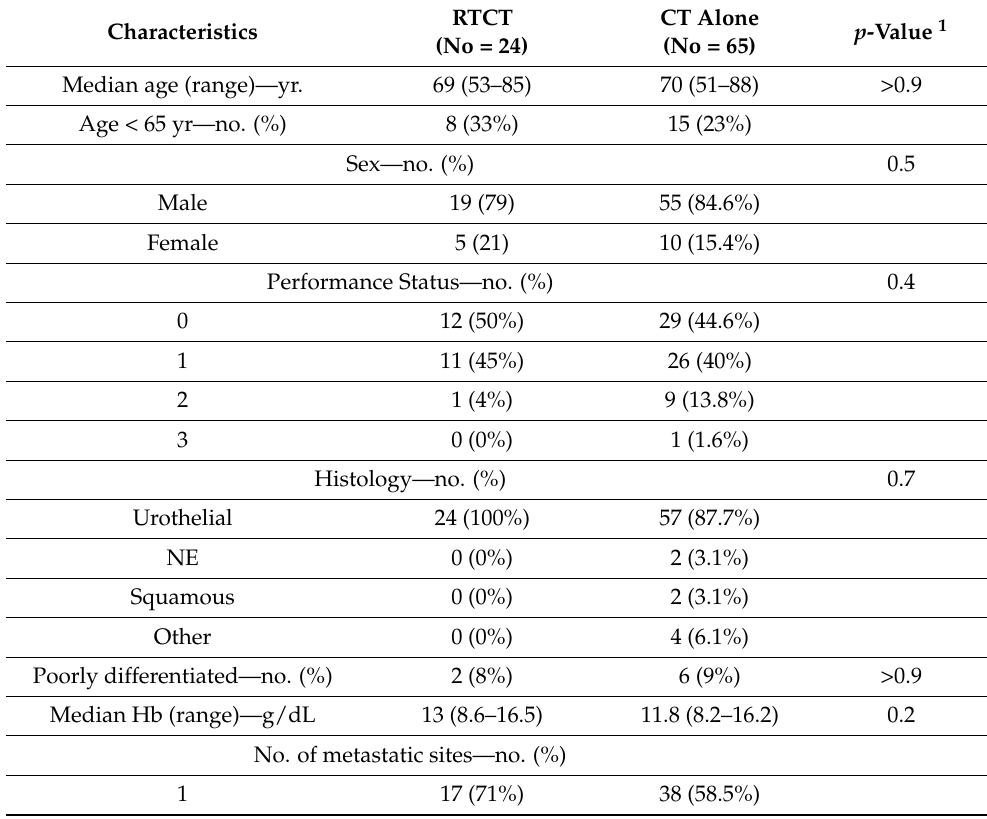
Table 1. Demographic and clinical